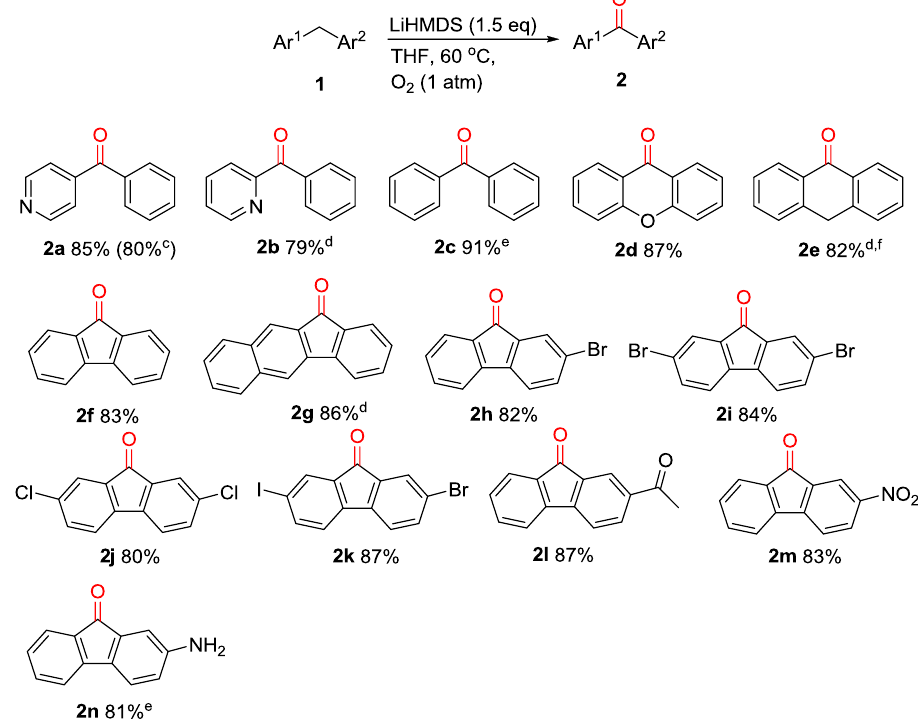
Figure 1. Scope of diarylmethanes in metal-free oxidation a,b . a Reactions were conducted on a 0.1 mmol scale using 1 equiv of 1, 1.5 equiv of LiN(SiMe 3 ) 2 at 0.1 M. b Isolated yield. c Reaction conducted on 5 mmol scale. d LiHMDS was replaced with NaHMDS. e LiHMDS was replaved with KHMDS. f 80 °C.